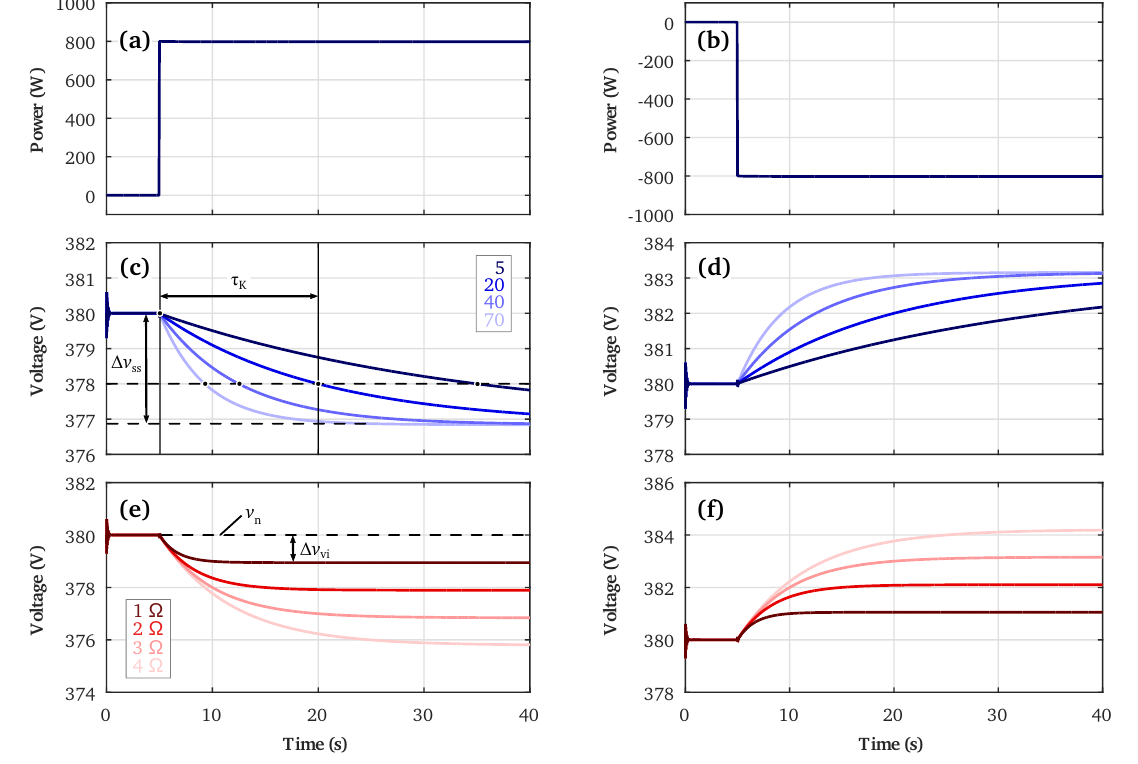
Figure 7. Variation of control parameters in the proposed virtual-impedance-based technique: ( a , b ) Microgrid power variations; ( c , d ) Voltage variations for different LPF gain values ( Z V = 3 Ω ); and ( e , f ) Voltage variations for different virtual-impedances ( K LPF = 60).